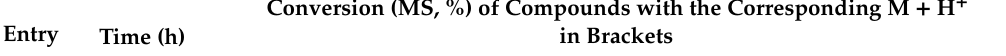
Table 1. Conversion values measured by HPLC-MS based on the TIC.